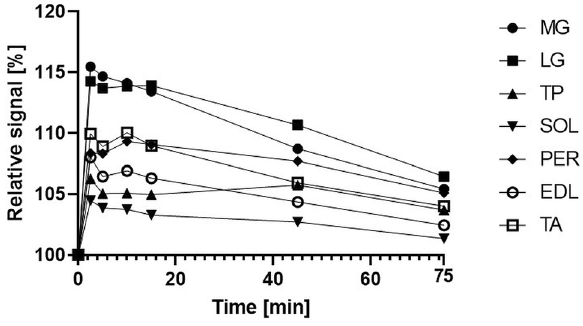
Figure 3. Relative changes of all muscles over time.